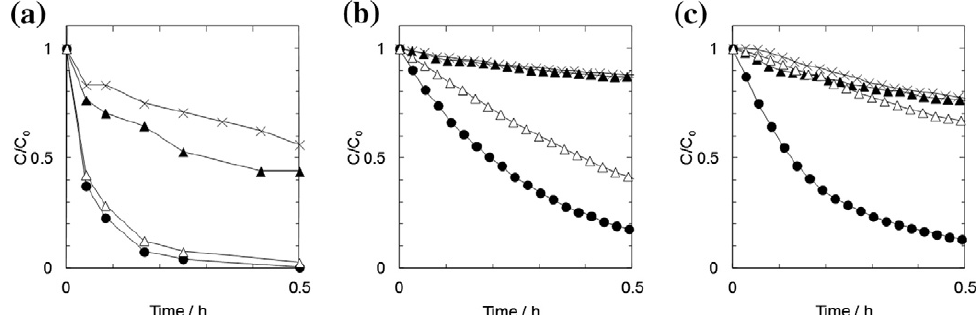
Figure 13. Degradation of ammonia ( a ), acetaldehyde ( b ), and acetic acide ( c ) with the combined air filter (filled circles), only PACT (empty triangles), only the TMiP filter (filled triangles) and without filter (crosses). (Reprinted/adapted with permission from Ref. [118]).